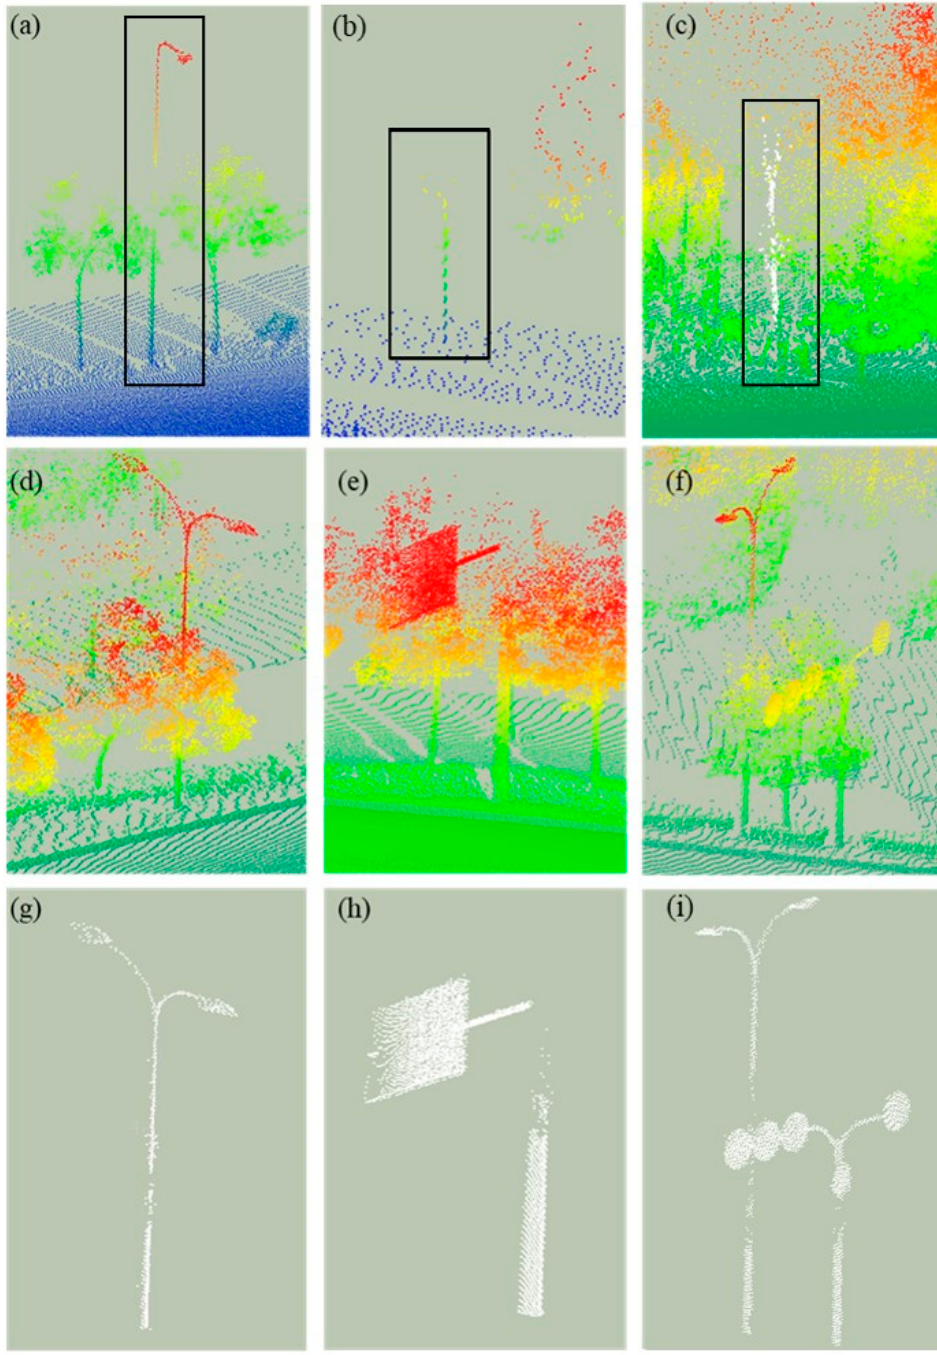
Figure 13. Sample results: ( a ) A lamppost undetected because of occlusion; ( b ) A lamppost undetected because of low density; ( c ) A lamppost undetected because of front tree occlusion; ( d ) A lamppost in a cluttered scene; ( e ) A traffic sign in a cluttered scene; ( f ) A lamppost and a traffic sign in a cluttered scene; ( g ) Detection result of ( d ); ( h ) Detection result of ( e ); ( i ) Detection result of ( f ).